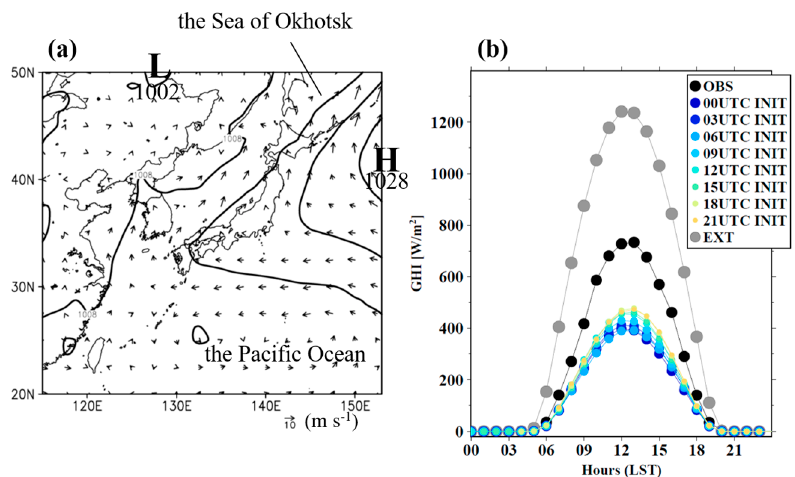
Figure 8. ( a ) Weather chart at 09 JST on 29 July 2016. ( b ) Time series of hourly GHI observations (black circles), meso-scale model (MSM) forecasts (colors), and extra-terrestrial solar irradiance on the same day for the integrated region of the nine electric power companies’ areas. Table 8. Same as Table 6, but for 29 July 2016.